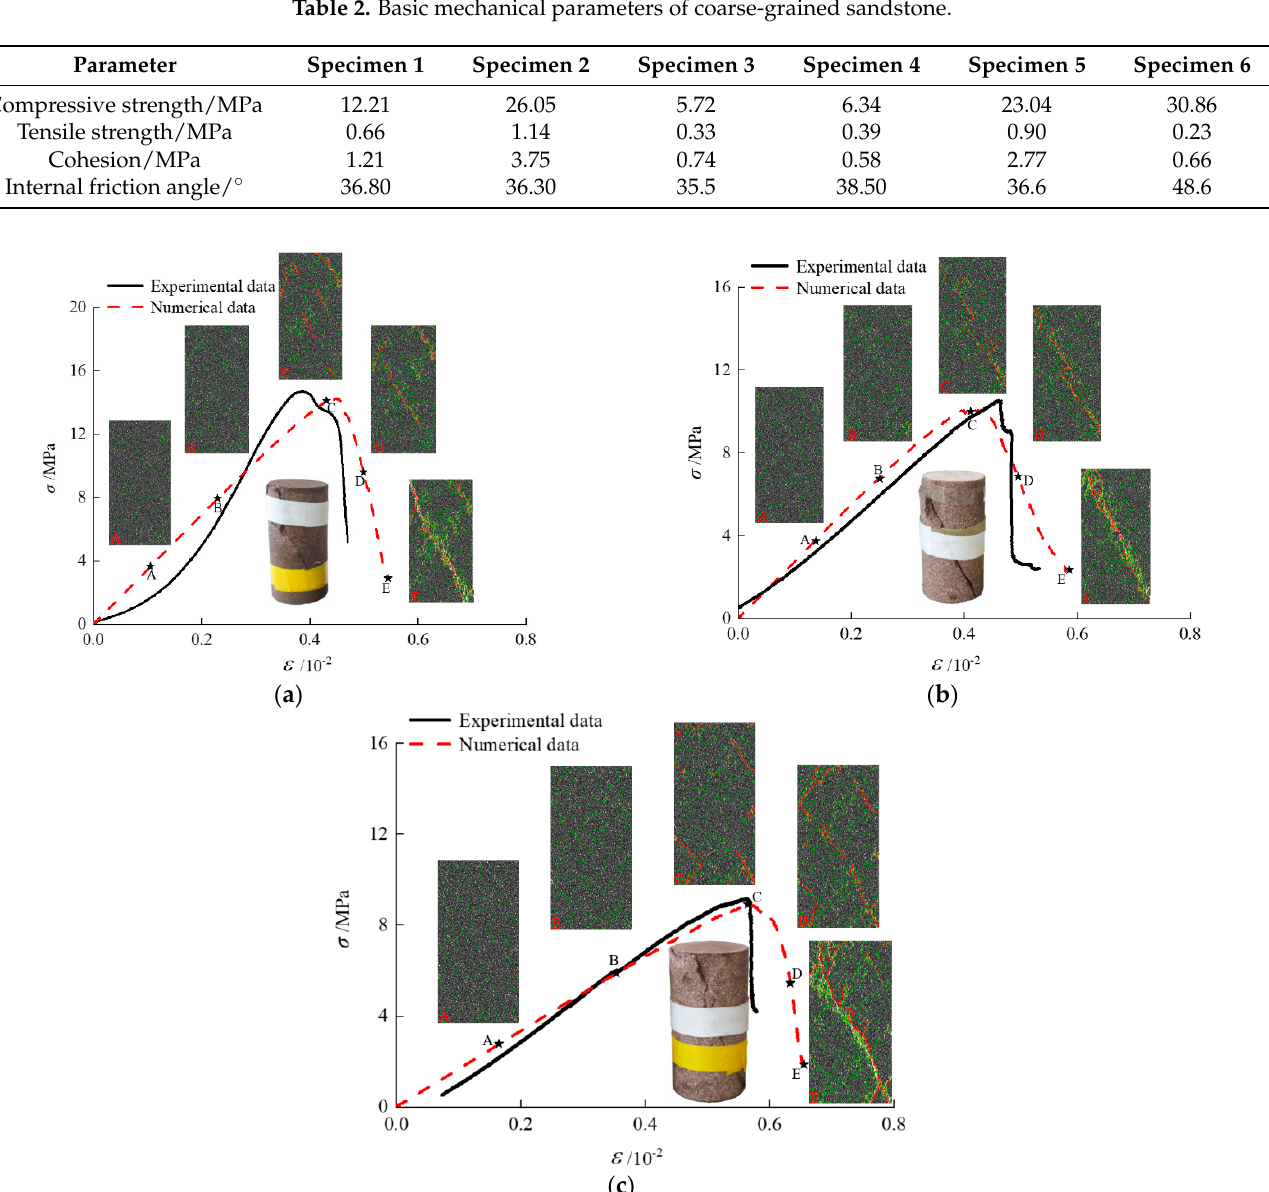
Figure 10. Stress-strain curve and crack evolution of coarse-grained sandstone: ( a ) coarse-grained sandstone sample 1; ( b ) coarse-grained sandstone sample 2; ( c ) coarse-grained sandstone sample